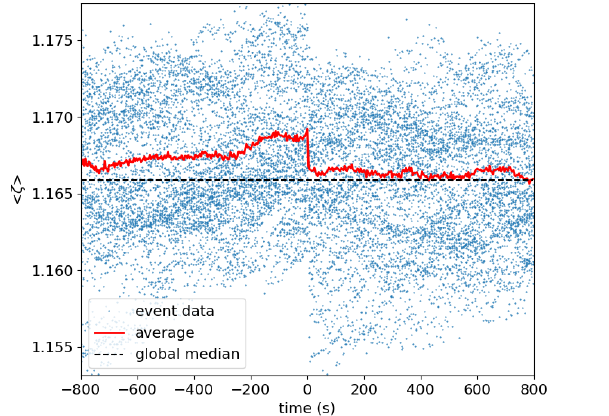
Figure 5. Each dot corresponds to the ζ parameter (inversely correlated with local density) averaged within the shear band on one picture at a given time t from the 33 largest events. Solid curve: averaged over the 33 images found at a given time t